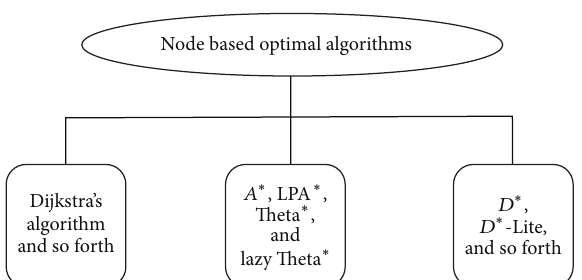
Figure 3: Elements of sampling based algorithms.